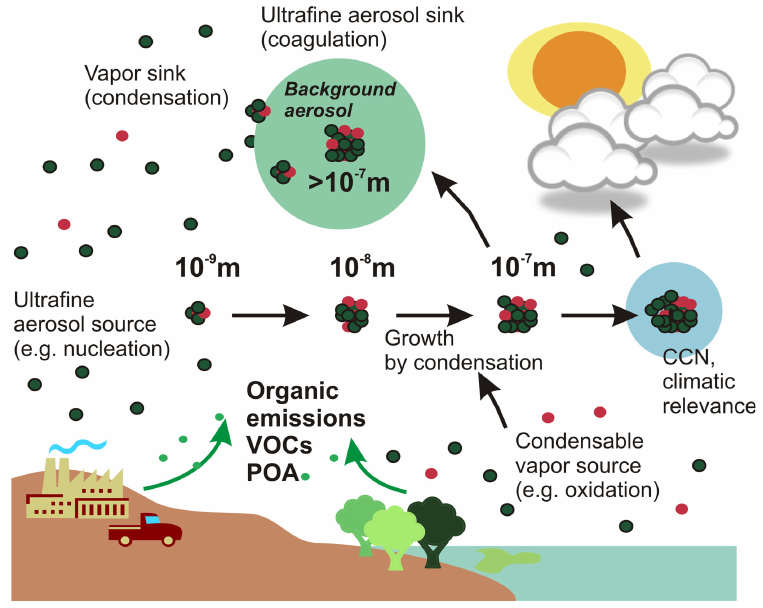
Fig. 1. Organic emissions and the dynamic processes governing the climatic importance of ultrafine aerosol. Condensable vapors are produced upon oxidation of volatile organic compounds (VOCs) and can (1) nucleate to form new small particles; (2) grow freshly formed particles to larger sizes and increase their probability to serve as CCN; (3) condense on the background aerosol ( > 100nm) and enhance the loss of ultrafine particles. Primary organic aerosol (POA) contributes to the large end of the aerosol size distribution, enhancing the scavenging of the ultrafine